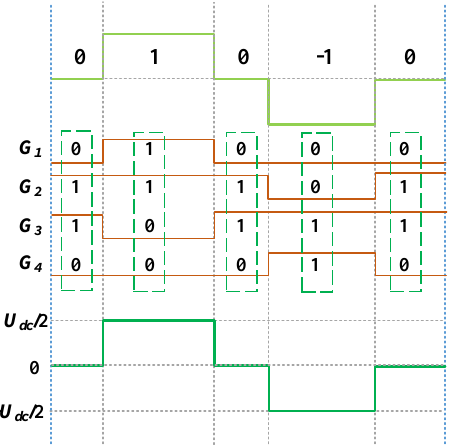
Figure 2. The switching signal and ideal supply voltage of the TL-NPC inverter.